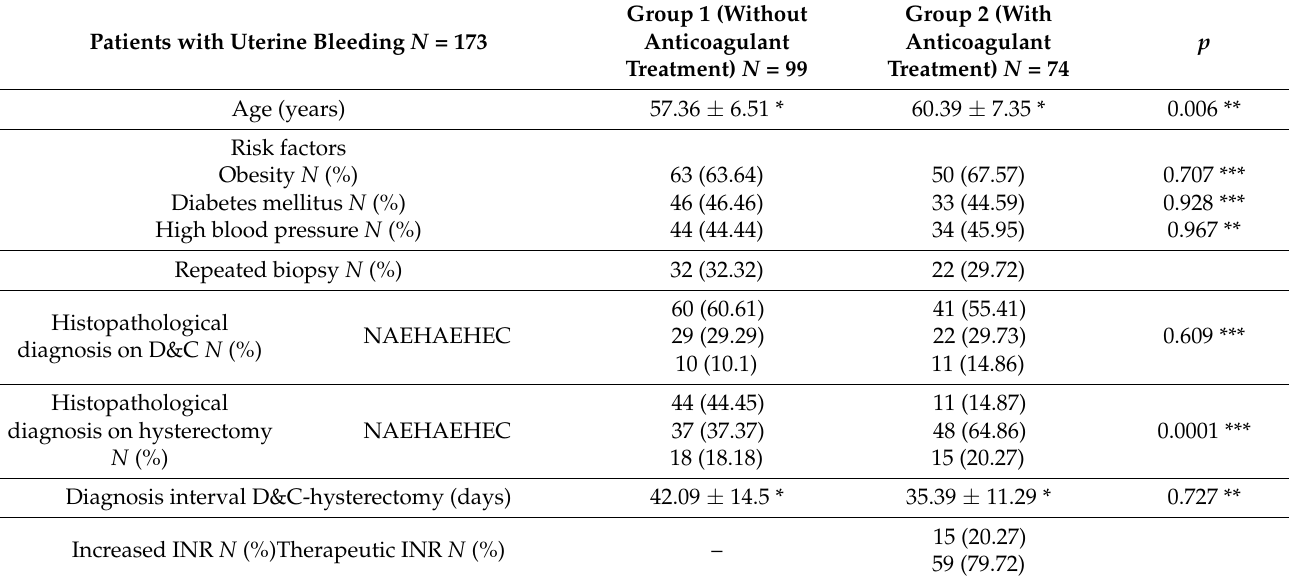
Table 1. Characteristics of patients in the two study